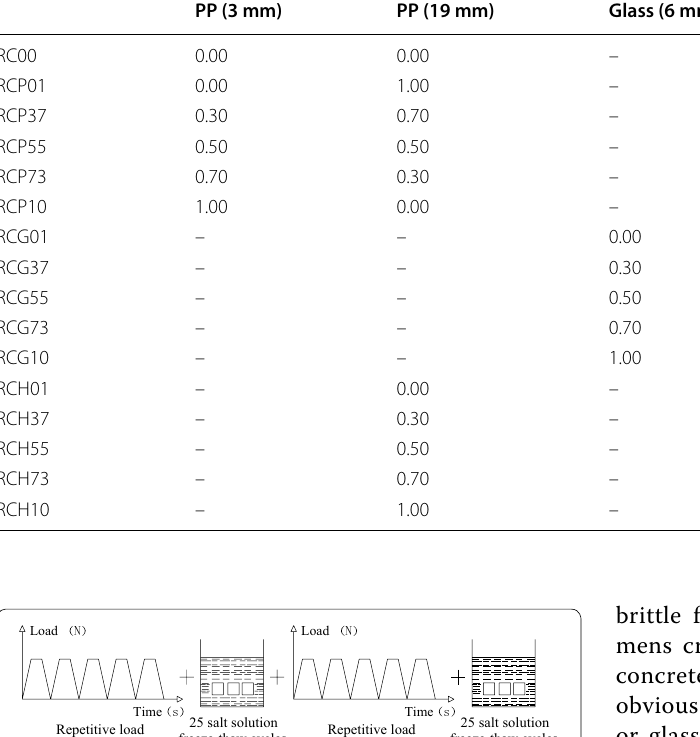
Table 4 Compressive strength of recycled aggregate concrete at age of 28 days. Specimen